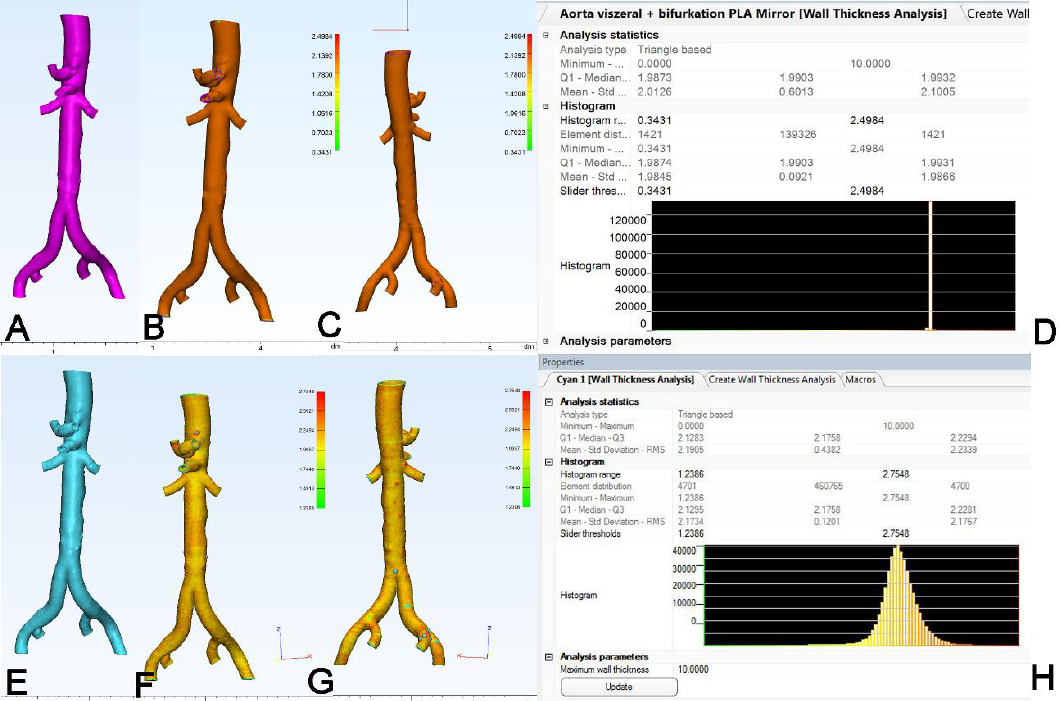
Figure 5. Analysis of wall thickness of the 3D model. For internal validation, ( A ): the source STL was subjected to automated analysis of wall thickness. ( B , C ): Results of wall thickness analysis as a color-coded map of the object where ( B ): is the anterior view and ( C ): is the posterior view. ( D ): Histogram of wall thickness analysis (WTA) showing a sharp band at 1.99 mm. For the STL of the ( E ): 3D model, the results of WTA are shown as a color-coded map in ( F ): anterior view, ( G ): posterior view and ( H ): histogram.